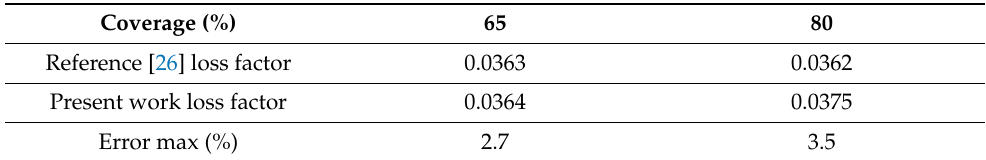
Table 4. The first loss factor of coverage variations of the ACLD patch on the first mode for a 1.5 mm- thick viscoelastic material (VEM) layer.